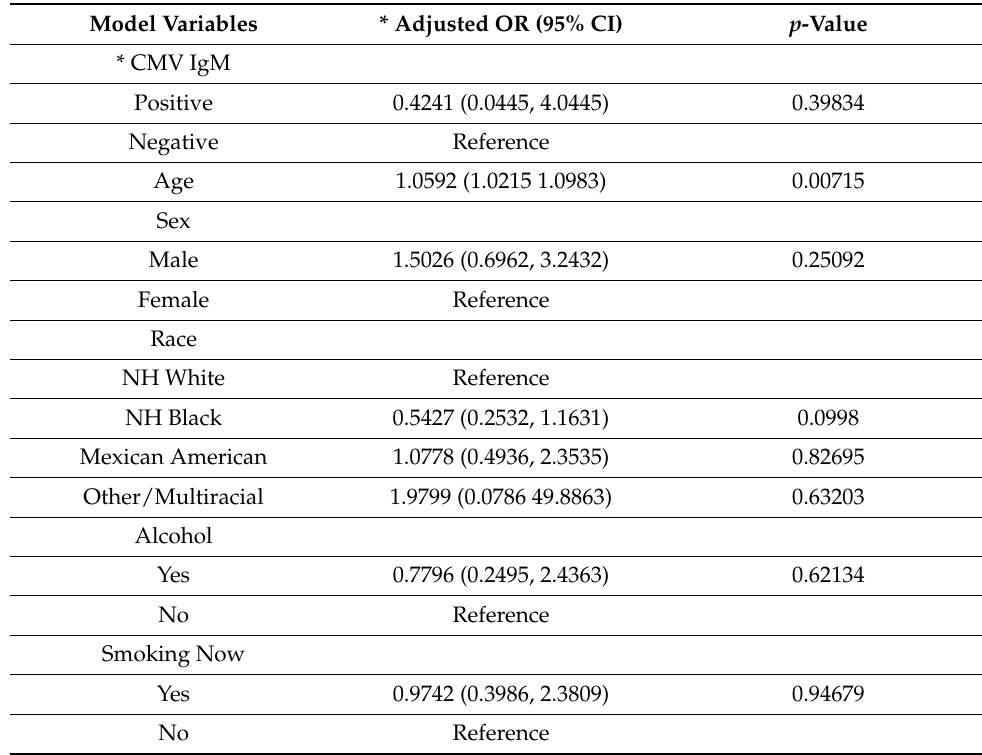
Table 3. Results of binary logistic regression for AL on CMV (IgM+/IgM − )—adjusting for the demographic and behavioral